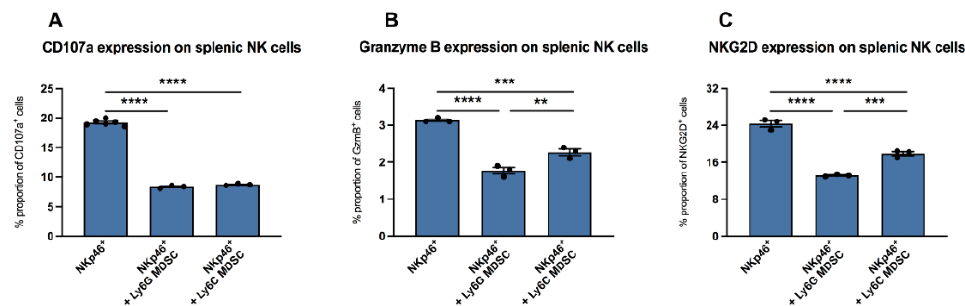
Figure 2. MDSC increased the expression of CD107a, granzyme B, and NKG2D in NK cells in vitro. Impact of Ly6G MDSC (granulocytic) or Ly6C MDSC (monocytic) on NK cells (NKp46 + ) in presence of CVB3-infected co-cultured HeLa/RAW cells. ( A ) Effect on the degranulation marker CD107a ( B ) granzyme B expression and ( C ) NKG2D receptor expression on NKp46 + NK cells. The y-axis displays the percentual proportion of 20,000 measured splenic NK cells. Data are expressed as mean ± SEM and were analyzed with One-way ANOVA or Kruskal-Wallis test (** p < 0.01, *** p < 0.001, **** p < 0.0001 with n = 3–6 for NKp46 + , n = 3 for NKp46 + +Ly6G MDSC, and n = 3 for NKp46 + +Ly6C MDSC).